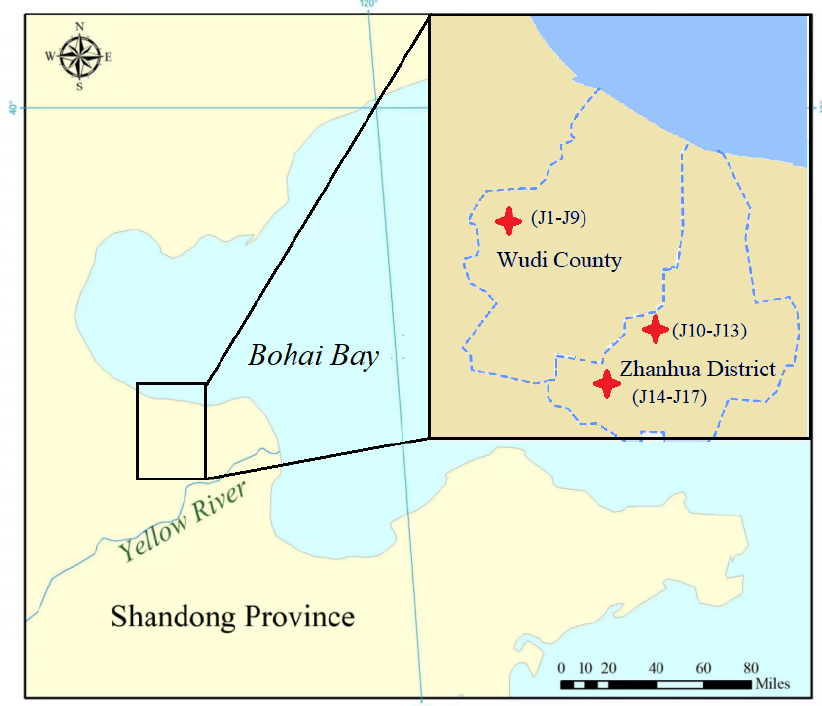
Figure 1. Sampling area in the Yellow River Delta.